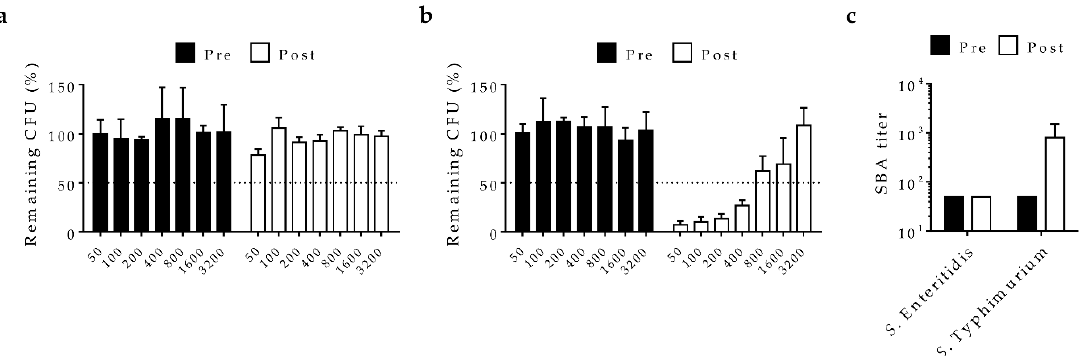
Figure 4. Complement-mediated bactericidal activity with sera from rabbits immunized with the trivalent typhoid-iNTS conjugate vaccine formulation. Viable colony forming units (CFU) were assessed after incubation with various dilutions of pooled pre-immune and post-vaccination trivalent sera with ( a ) S . Enteritidis S15 or ( b ) S . Typhimurium D65. Dashed line indicates 50% cutoff for titer determination. ( c ) Calculated serum bactericidal activity (SBA) titers. Bars represent mean and standard deviation from one experiment. Error bars were derived from technical replicates. Titers are representative of two independent assays.